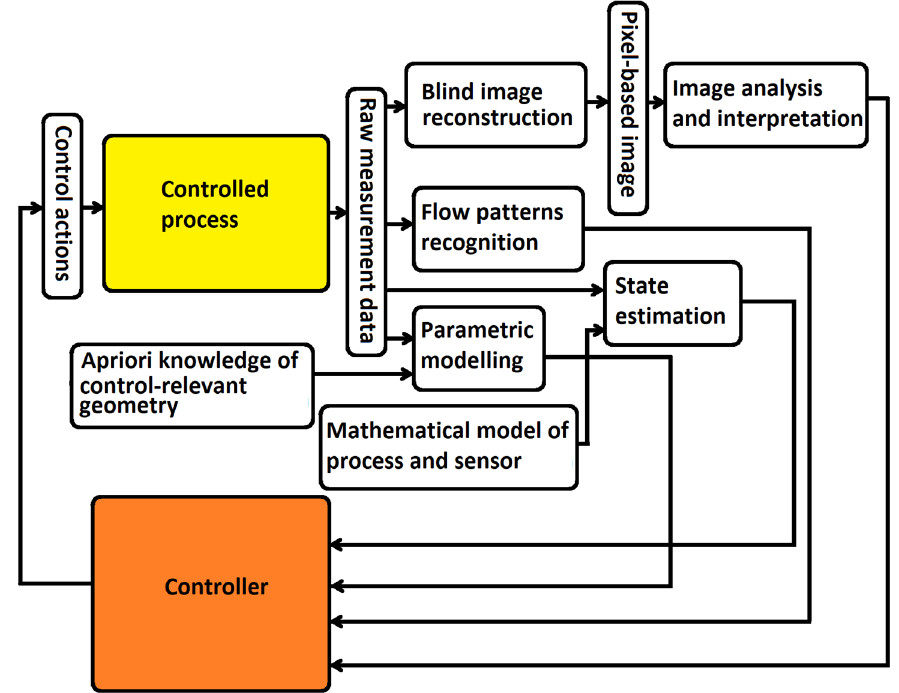
Figure 2. Main options for closing the control loop using tomographic measurements. Figure 2 . Main options for closing the control loop using tomographic measurements.